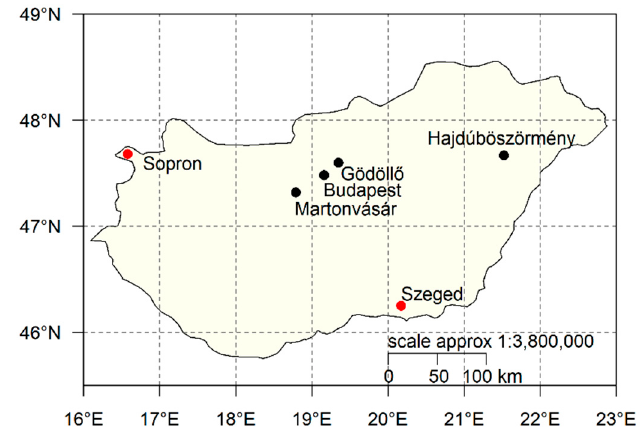
Figure 1. Locations of the cities where the collection of weather data is carried out and the thermal sensation observations are performed.